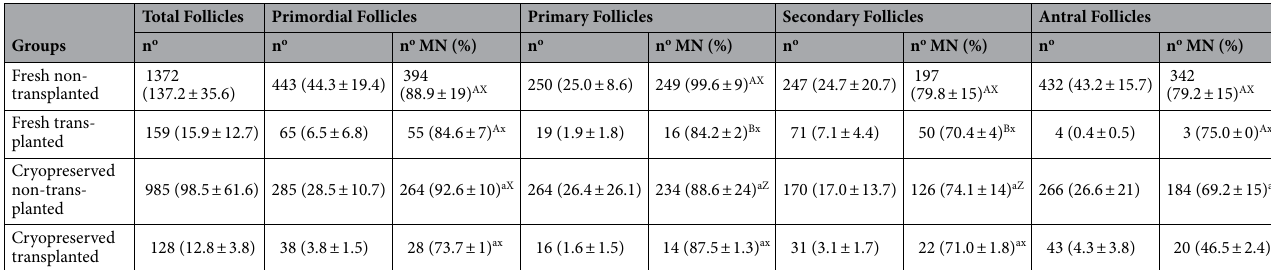
Table 1. Number of follicles and number and percentage of morphologically normal follicles (total, primordial, primary, secondary, and antral follicles) counted in samples of fresh and cryopreserved ovarian tissue, before and after transplantation. n o = total number of follicles, n o MN = number of morphologically normal follicles. Data within parentesis are mean ± SD. Different letters indicate significant difference ( p < 0.01), in the same column, according to the following code: A,B Difference between Fresh non-transplanted and Fresh transplanted groups. a,b Difference between Cryopreserved non-transplanted and Cryopreserved transplanted groups. X,Z Difference between Fresh non-transplanted and Cryopreserved non-transplanted groups. x,z Difference between Fresh transplanted and Cryopreserved transplanted